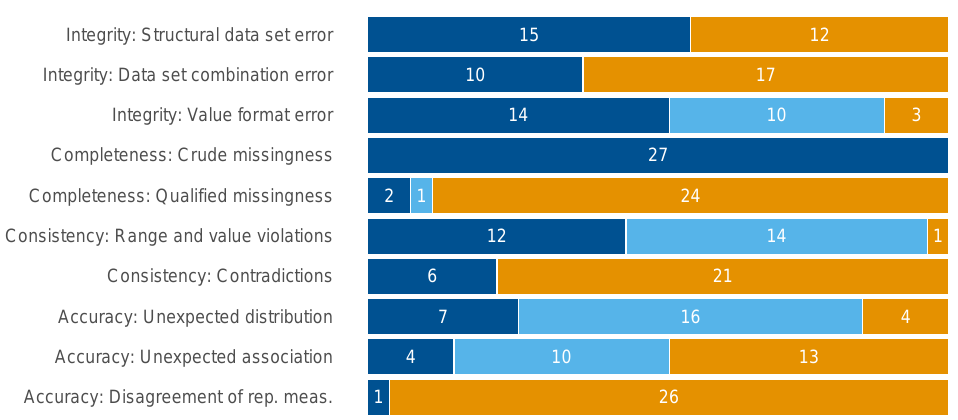
Figure 2. Number of packages with relevant output to detect issues in distinct data quality domains (Section 2.2.1) with respect to the total 27 packages included in this